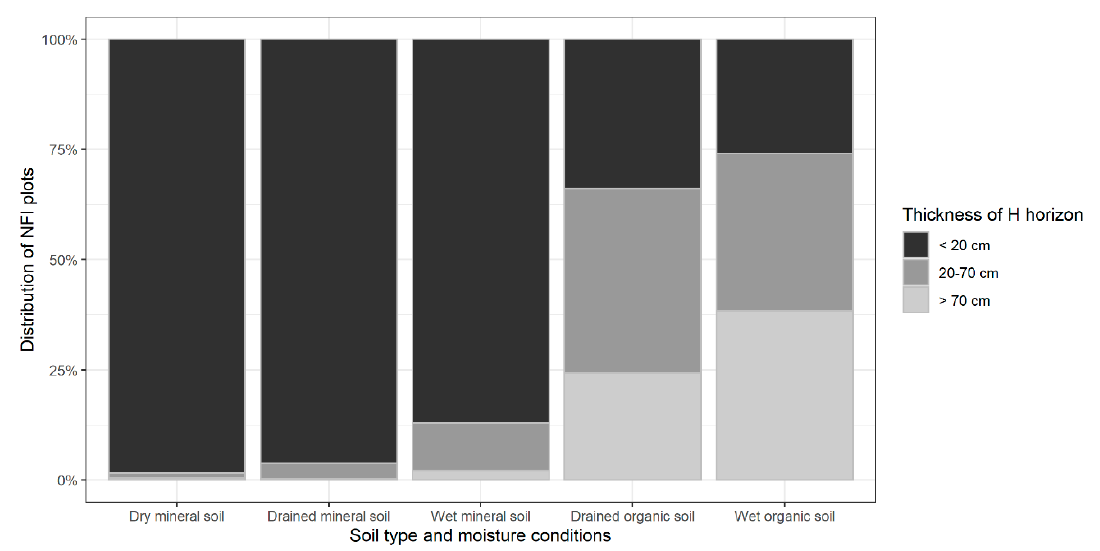
Figure 5. Distribution of NFI plots based on the thickness of the H horizon in forest land in Latvia. The division into groups based on soil types and moisture conditions is based on forest site types according to the national forest classification.